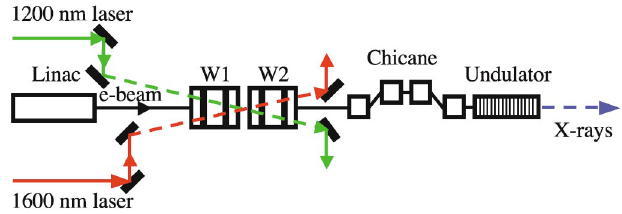
FIG. 1. (Color) A schematic of the components involved in attosecond x-ray pulse